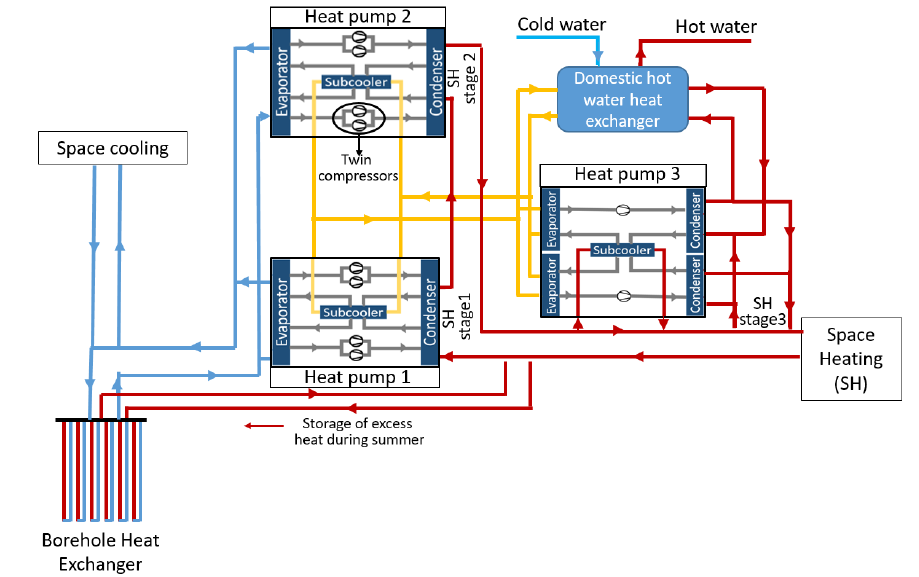
Figure 3. Schematic layout of the geothermal heating system.